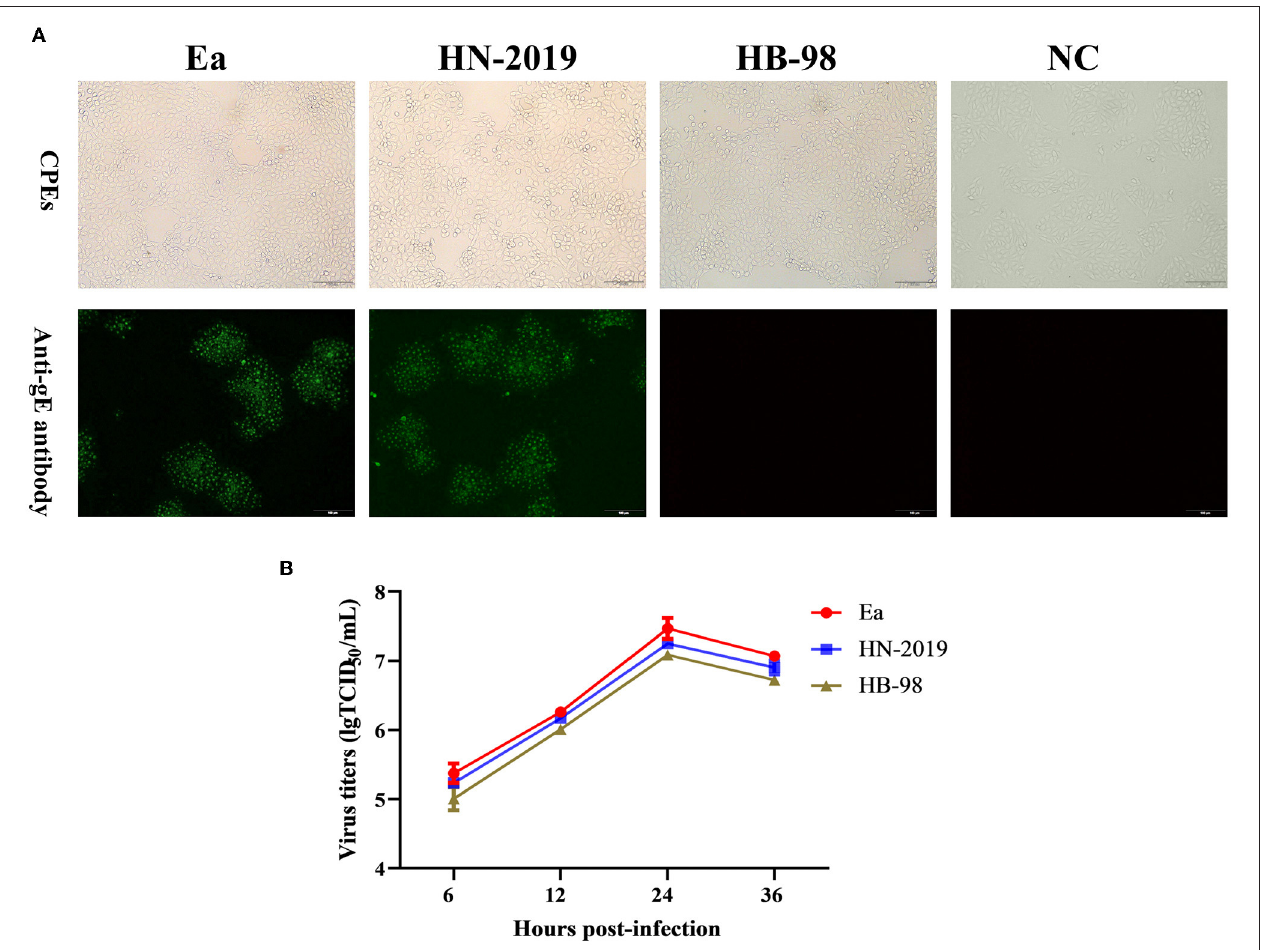
FIGURE 1 | The biological properties of a novel recombinant PRV strain (HN-2019), Ea, or HB-98 vaccine strains. The cytopathic effects (CPEs) in porcine kidney (PK15) cells infected with HN-2019 were characterized by rounded and floated cells, with the CPEs in HB-98 or Ea-infected PK15 cells set as positive controls (A , upper panels). Indirect immunofluorescent assay for detecting the gE protein in PK15 cells infected with HN-2019, Ea, or HB-98 vaccine strains, respectively (Scale bar = 100 µ m) (A , lower panels). One-step growth curves of three pseudorabies virus (PRV) strains in PK15 cells at an MOI of 1. The viral titers of them were determined by TCID 50 /ml (B)